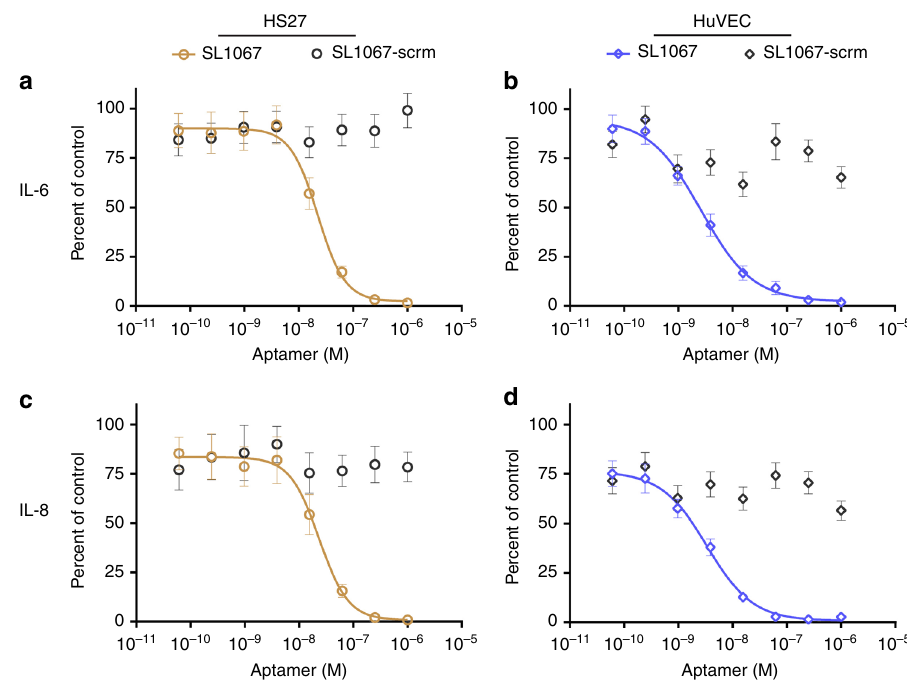
Fig. 8 A cell-based assay shows the inhibition of IL-1 α downstream signaling by SL1067 in a dose-dependent manner. Shown are the global fi ts (mean ±